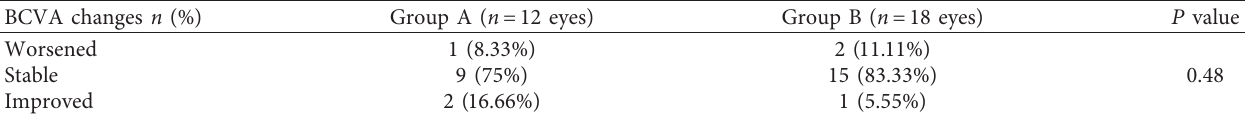
Table 5: BCVA changes in the two study groups.